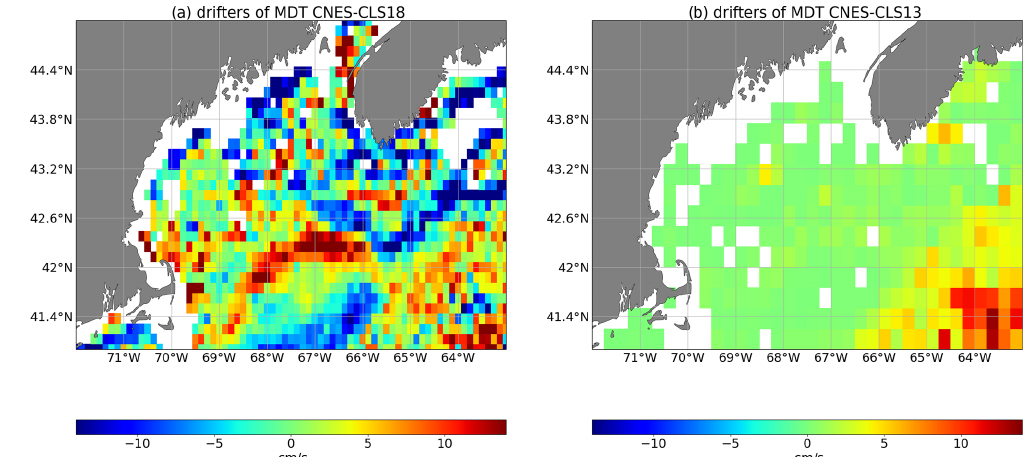
Figure 12. Zonal component of the mean synthetic velocities from drifters used in the computation of the (a) MDT CNES-CLS18 and (b) MDT CNES-CLS13.